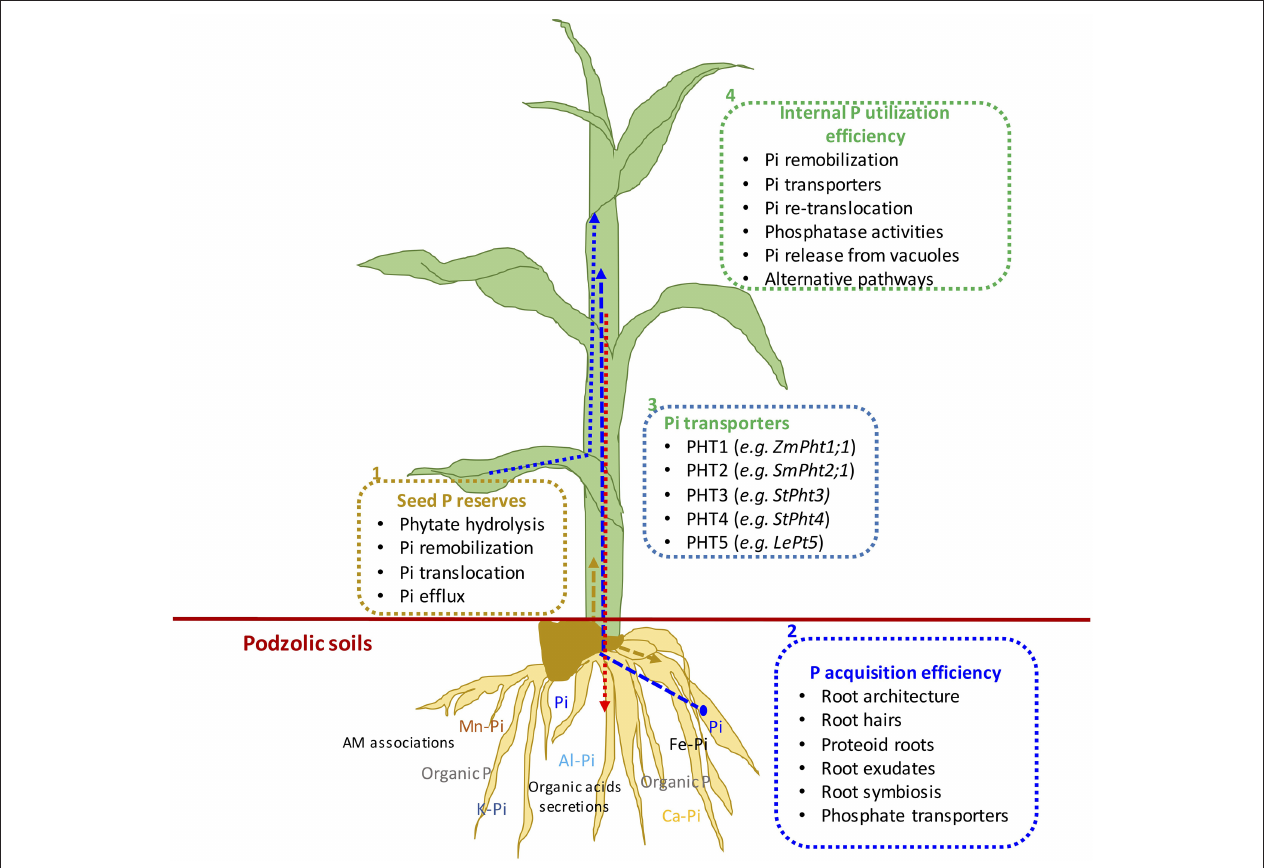
FIGURE 2 | (1) Schematic representation of mechanisms of seed phosphorus remobilization, (2) P acquisition efficiency, (3) P transporters, and (4) internal P utilization efficiency from germination to final plant harvest in maize plant. Dotted arrows show different P fluxes in growing seedlings: Blue represents external P uptake, gold represents remobilized seed P, and pink arrow shows P translocation from leaves to